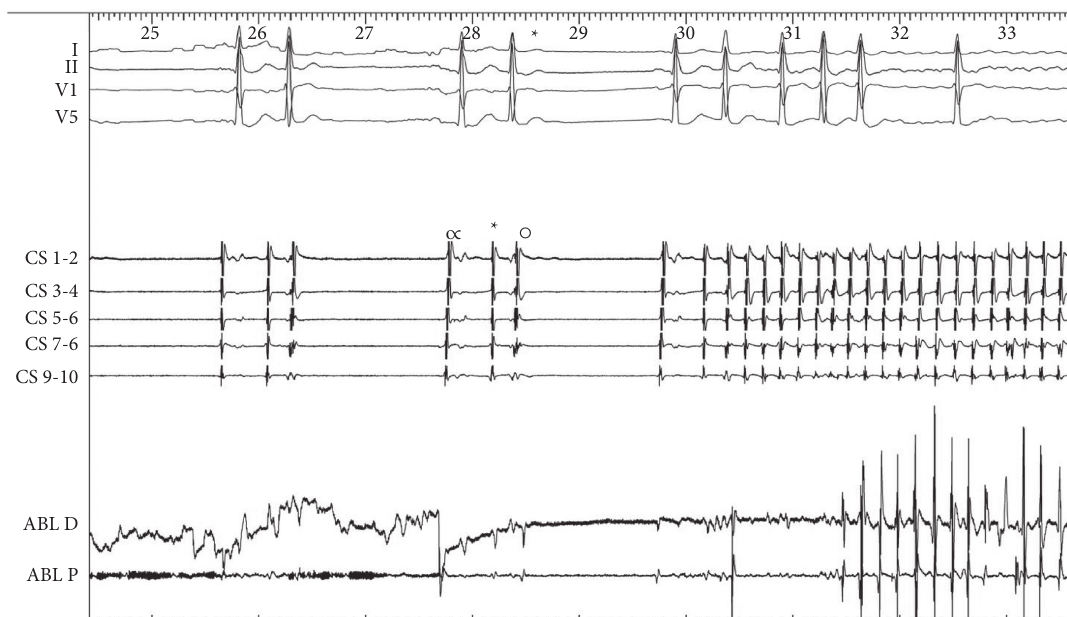
Figure 2: The trace shows the trigger of atrial fibrillation. It seems due to an extra systolic beat ( ∗ ), but the endocardial electrogram shows the following sequence: sinus beat ( ∞ ), extra systolic beat ( ∗ ), and blocked extra systolic beat ( ° ). This latter is the effective trigger of atrial fibrillation (CS: coronary sinus; ABL: ablator; D: distal; P: